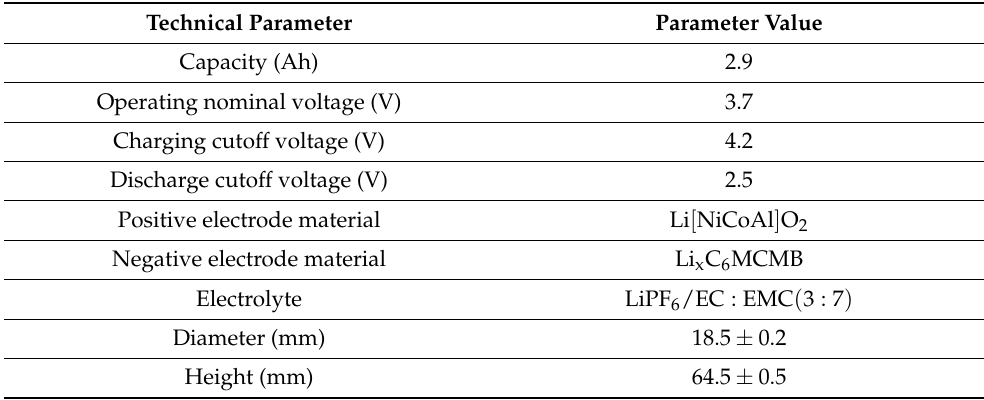
Table 1. Basic parameters of NCA lithium-ion battery.